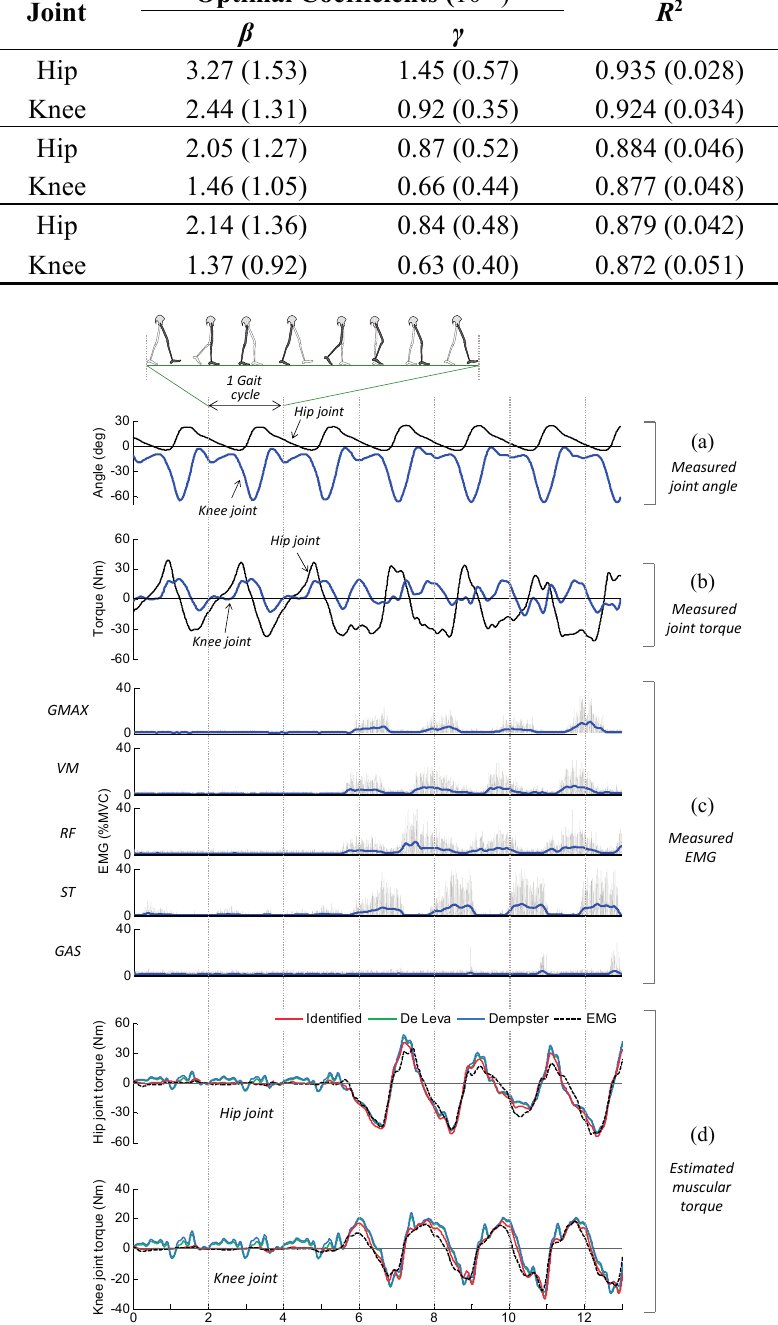
Figure 9. EMG signals and corresponding muscular torques resulting from the experiment on gait training (subject 1). ( a ) Measured joint angle; ( b ) Measured joint torque; ( c ) Measured EMG; ( d ) Estimated muscular